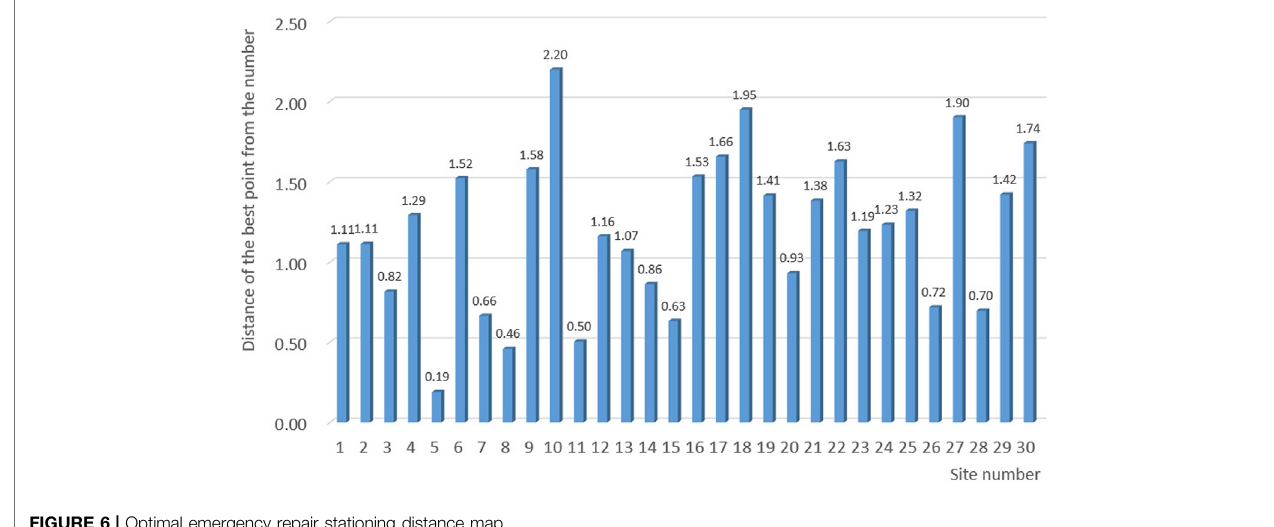
FIGURE 6 | Optimal emergency repair stationing distance map.